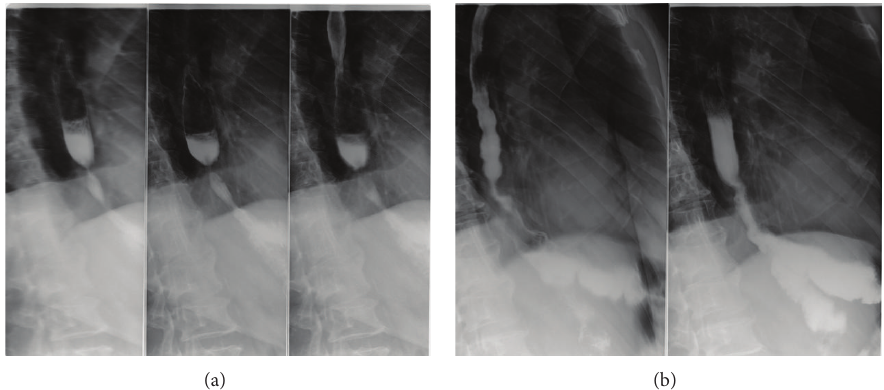
Figure 4: Abdominal X-ray: before (a) and after (b) balloon